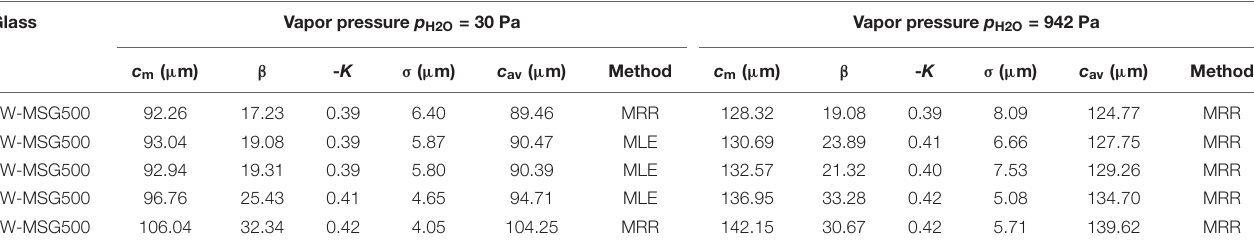
TABLE 2 | Scale parameter c m , shape parameter β , skewness parameter K , standard deviation σ , and mean length c av of Weibull distributed crack lengths c 50s (propagation time t − δ = 50 s). The skewness parameter K calculates as K = ( c av - c m )/ σ . Weibull distributions were fitted using median-rank regression (MRR) and maximum likelihood estimators